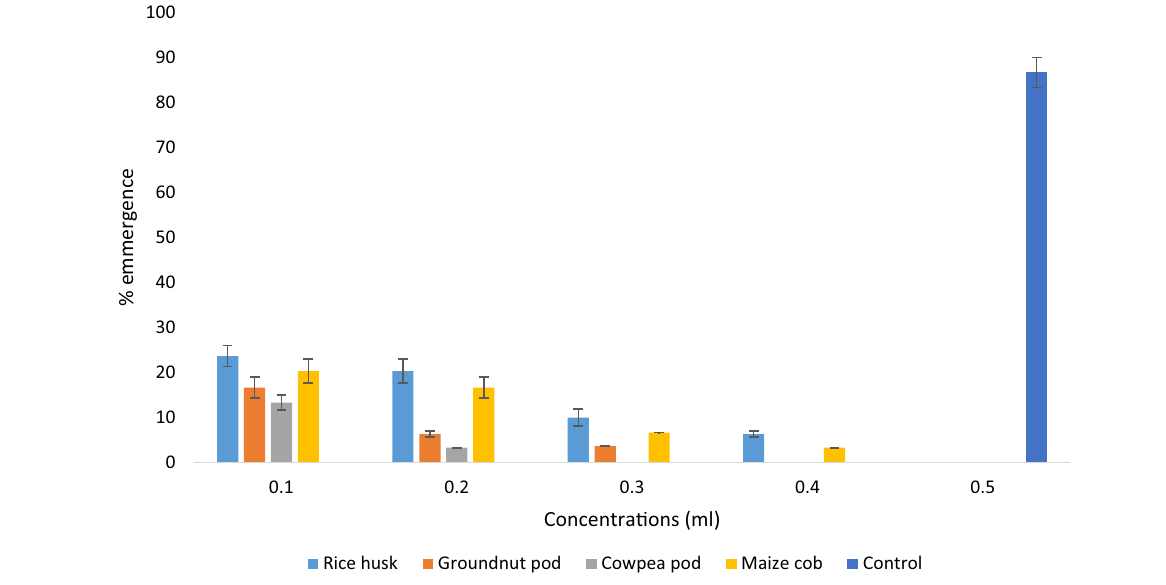
Fig. 2 Adult emergence of Sitotroga cerealella treated with agricultural waste extracts